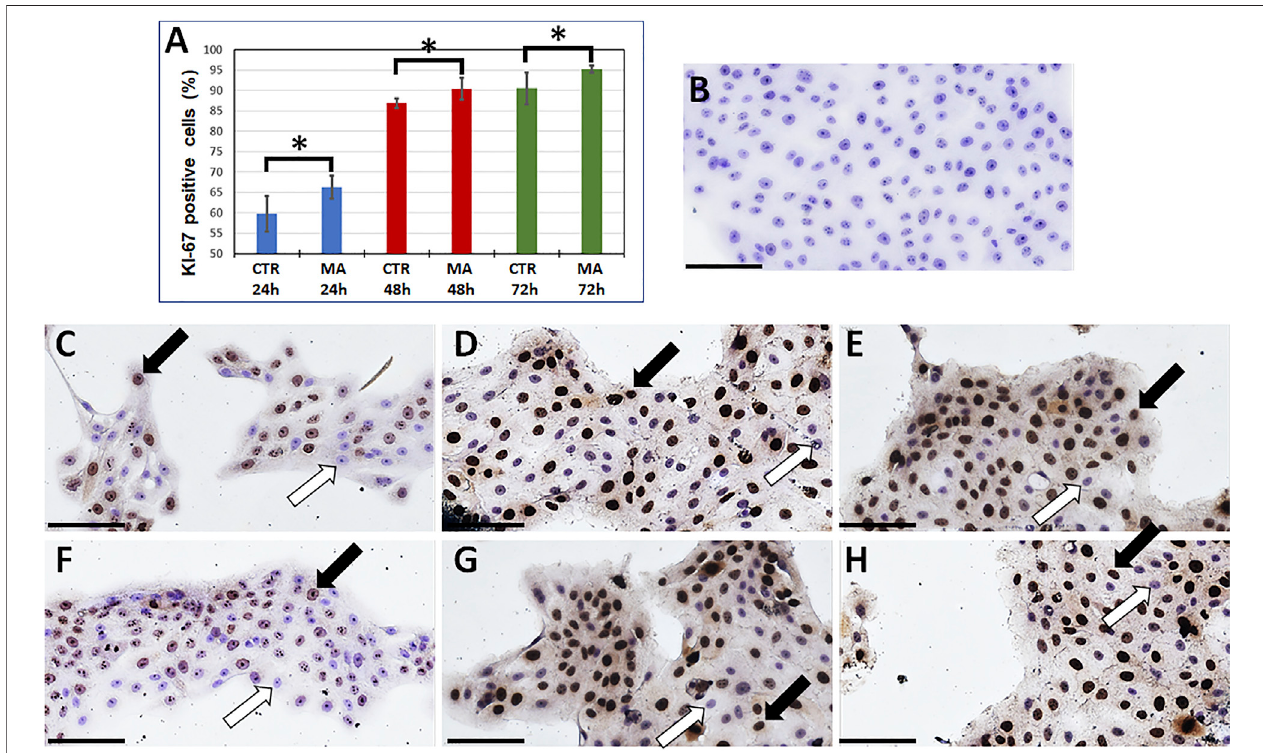
FIGURE 3 | Immunohistochemical analysis of the cell-proliferation marker KI-67 in immortalized human keratinocytes cultured presence or absence of maslinic acid. The cells were cultured in the presence of 5 μ g/ml of maslinic acid (MA) or in absence of this compound (Control CTR) for 24, 48 or 72 h. (A) : Percentage of cells showing KI-67 positive signal in each study group. Error bars represent standard deviations, and asterisks show statistically-signi fi cant differences with CTR for the Mann-Whitney test. (B) : Histological image of negative control cells (no primary antibody) showing no expression of KI-67. (C – H) : Illustrative images of cells showingpositiveand negative cells inthedifferentstudy groups. (C,D,E) :CTR; (F,G,H) :MA atthe concentrationof5 μ g/ml; (C,F) :24 h, (D,G) : 48 h, (E,H) : 72 h. Some cells showing positive expression of KI-67 are labeled with black arrows, and white arrows correspond to negative cells. Scale bars: 100